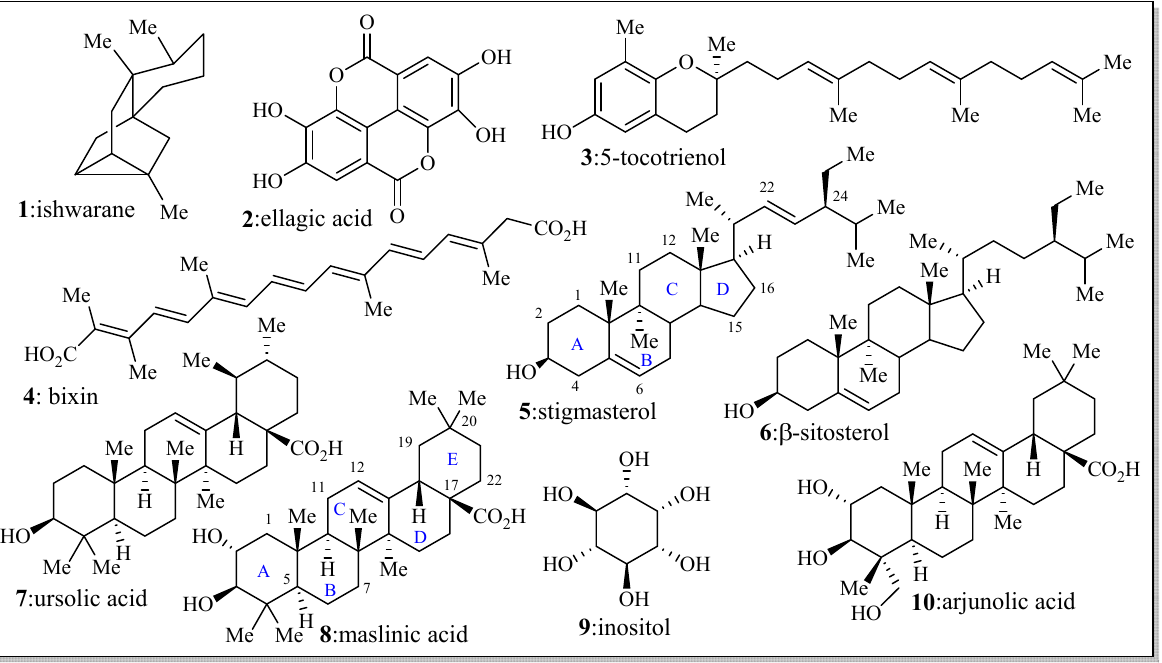
Figure 2. Isolated natural products from B. orellana hairy root